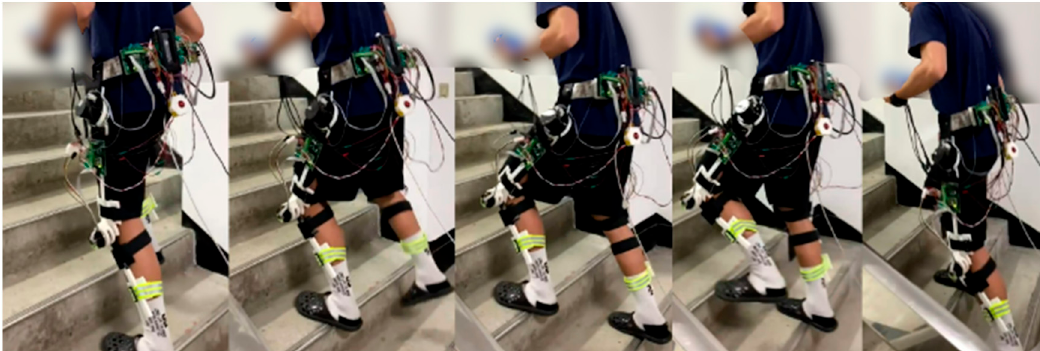
Figure 13. Ascending gait training with robotic hip-knee exoskeleton.